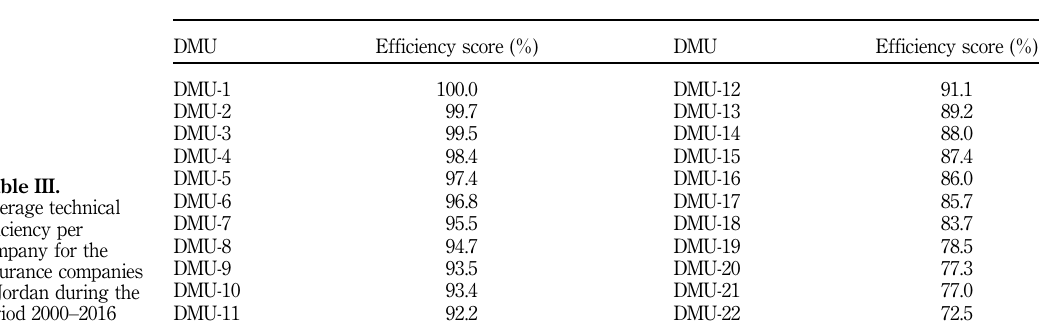
Table II. Average technical efficiency per year for the insurance companies in Jordan during the